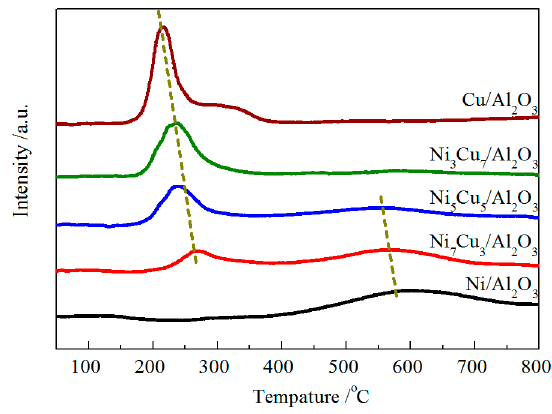
Figure 3. H 2 -temperature programmed reduction (H 2 -TPR) profiles of Ni x Cu (10 − x ) / γ -Al 2 O 3 catalysts.